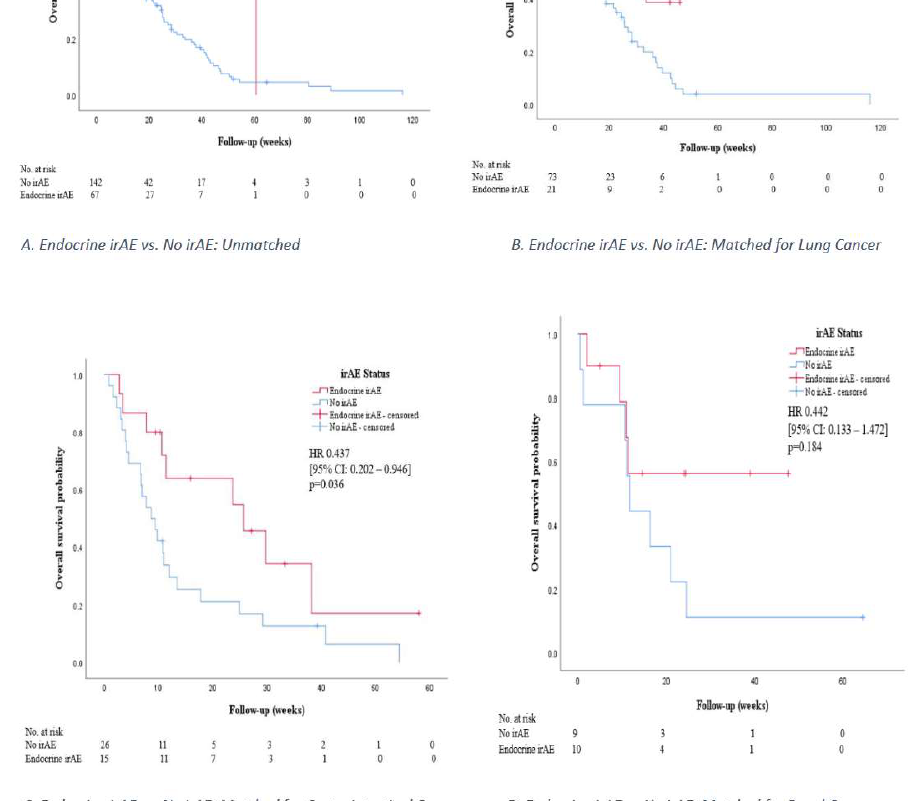
Figure 5. Kaplan–Meier curves for overall survival according to endocrine irAE status. The presence of endocrine irAE was associated with nonprogressive disease. The odds ratio for non-progressive disease in patients with endocrine irAE compared to pa- tients without irAE was 173.1 (95% confidence interval: 27.0 to 6962.0; p -value < 0.001).